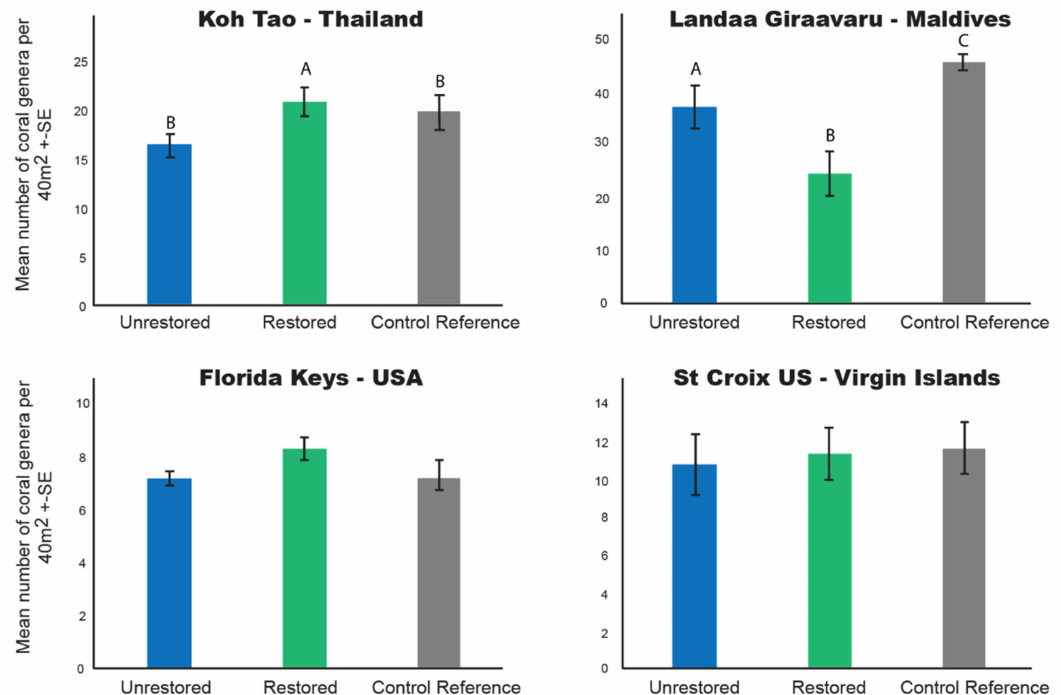
Figure 7. Mean number of coral genera per 40-m 2 belt transect ( ± SE) compared among treatments (unrestored, restored, control reference sites) at each of the four locations. Letters above each histogram indicate whether mean values di ff er significantly (di ff erent letters) or are statistically indistinguishable (same letters). n = 9 transects per treatment in Koh Tao, Landaa Giraavaru, and the Florida Keys; in St Croix, n = 8 transects for unrestored and restored treatments, n = 6 transects for the control reference